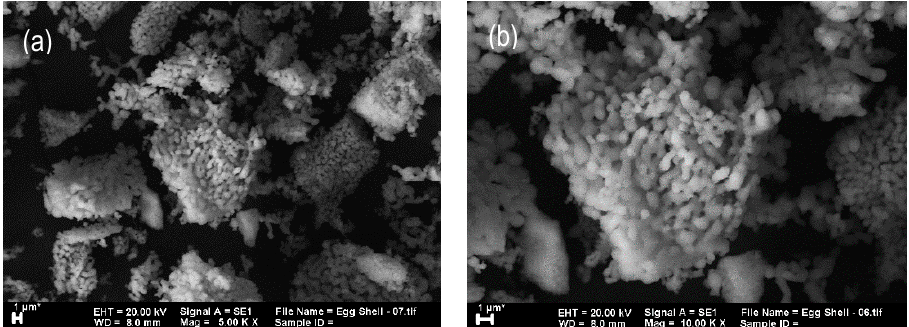
Figure 3. The SEM morphology of CaO-KOH catalysts powder with magnification of ( a ) 5000 × ( b ) 10,000 × .